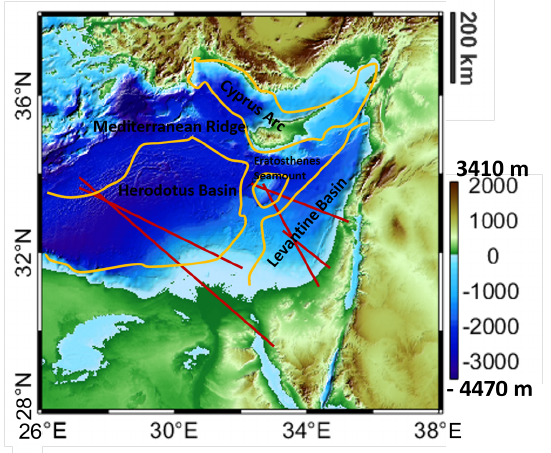
Figure 2. The Levant Basin with the boundaries of its main geological provinces (orange lines) and the available seismic profiles (red